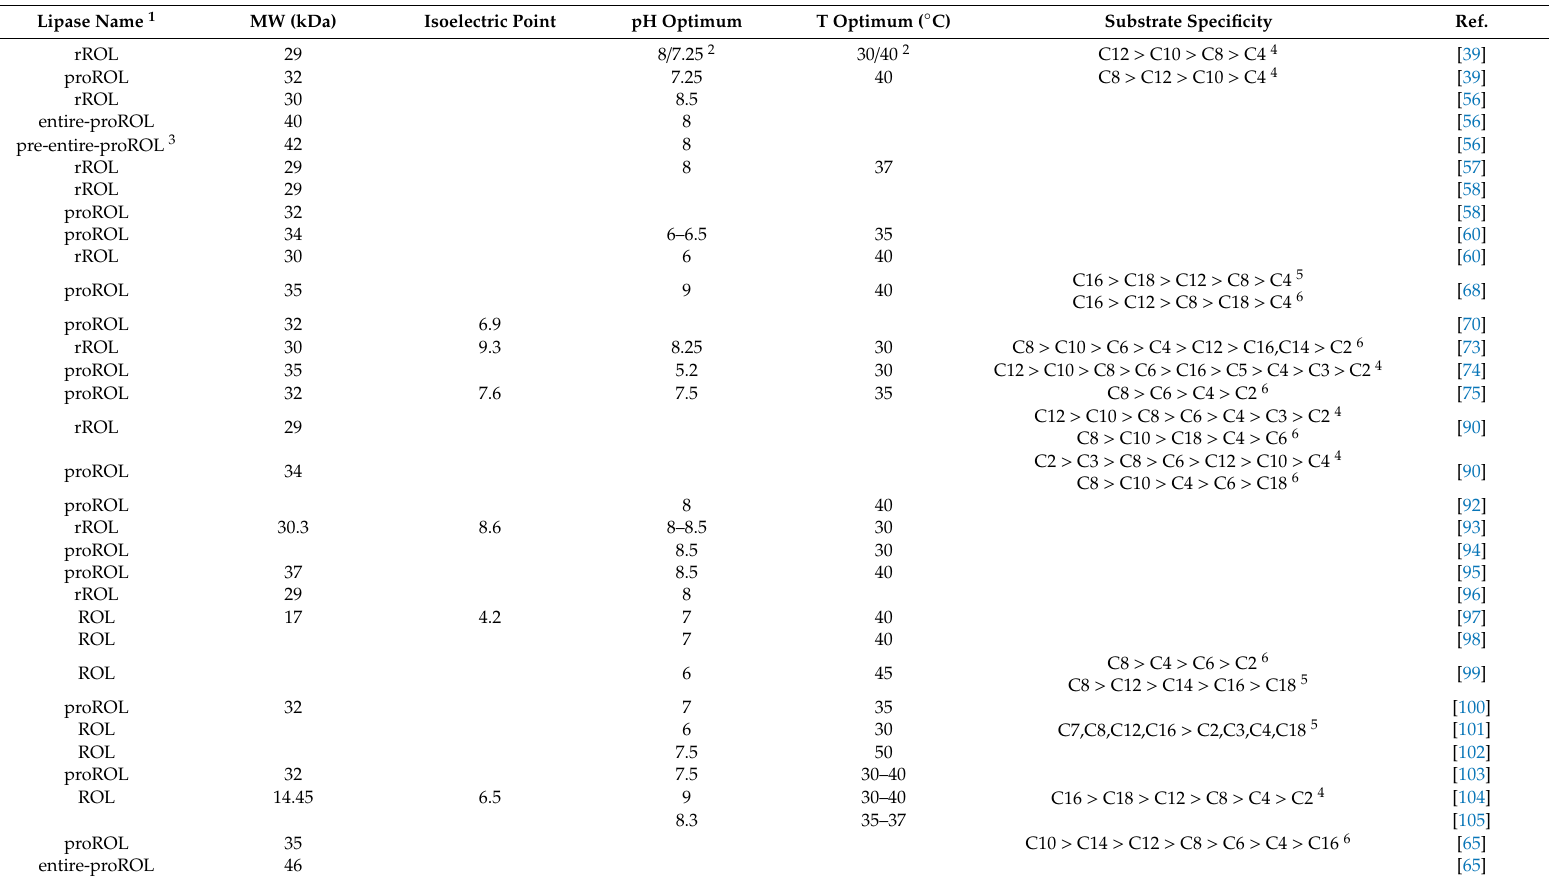
Table 2. Biochemical properties and substrate specificity of di ff erent published works dealing with